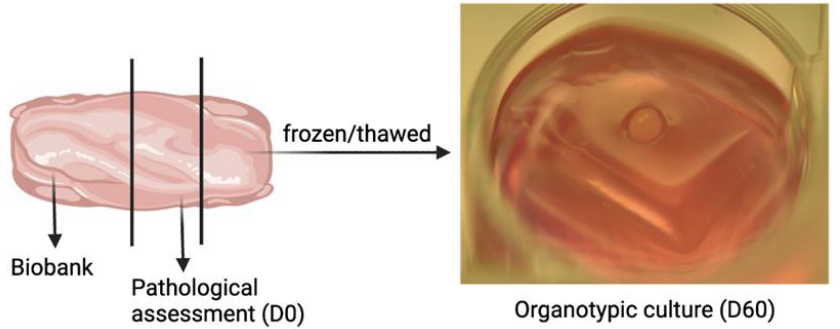
Figure 7. Organotypic culture of immature testis tissue (ITT) from cryptorchid boy. The testis tissue was cut into three fragments for biobank, pathological assessment, and organotypic culture use. The tissue fragment (1 – 1.5 mm 3 ) was placed on an agarose gel stand with an air-liquid interface. D = day.